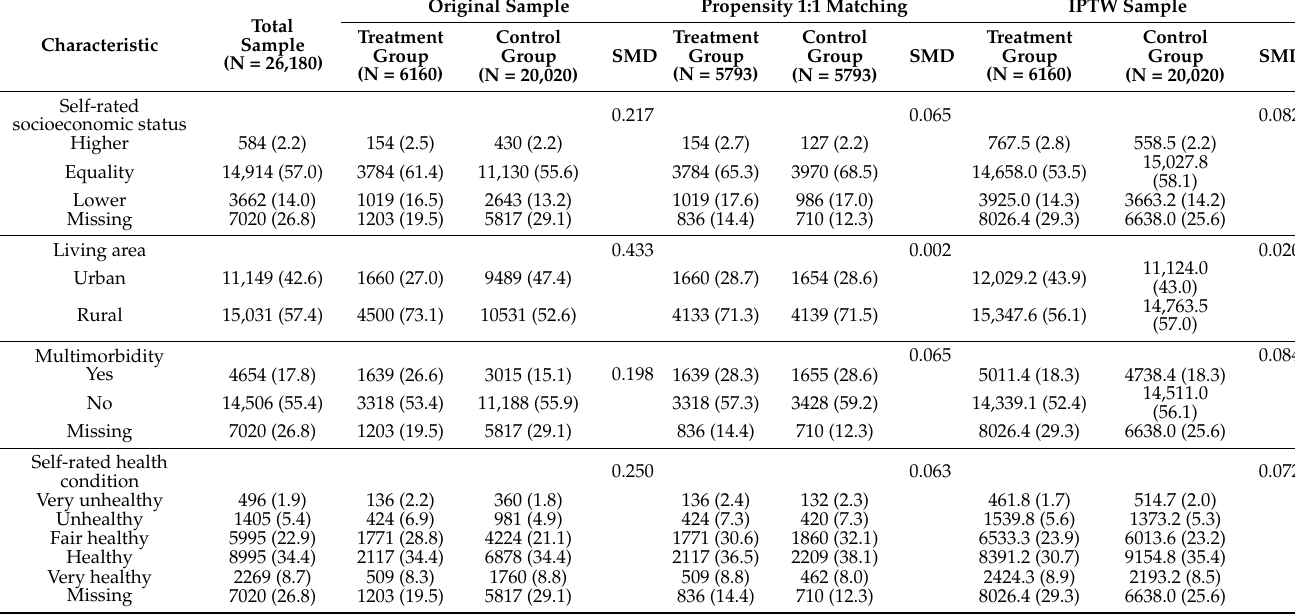
Figure 2. Association between HBVIDV program and outcomes in original sample ( A ), propensity score–matched sample ( B ) and inverse probability of treatment–weighted sample ( C ), stratified by